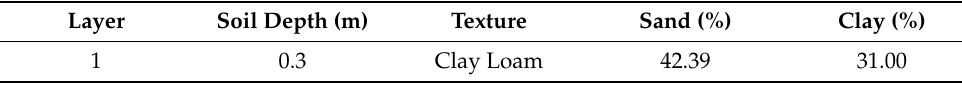
Figure 4. Percentage change in the estimated soil moisture depths estimated when ( a ) sand content was adjusted, ( b ) clay content was adjusted, and ( c ) both sand and clay content were adjusted. Table 3. Soil properties used during model calibration.